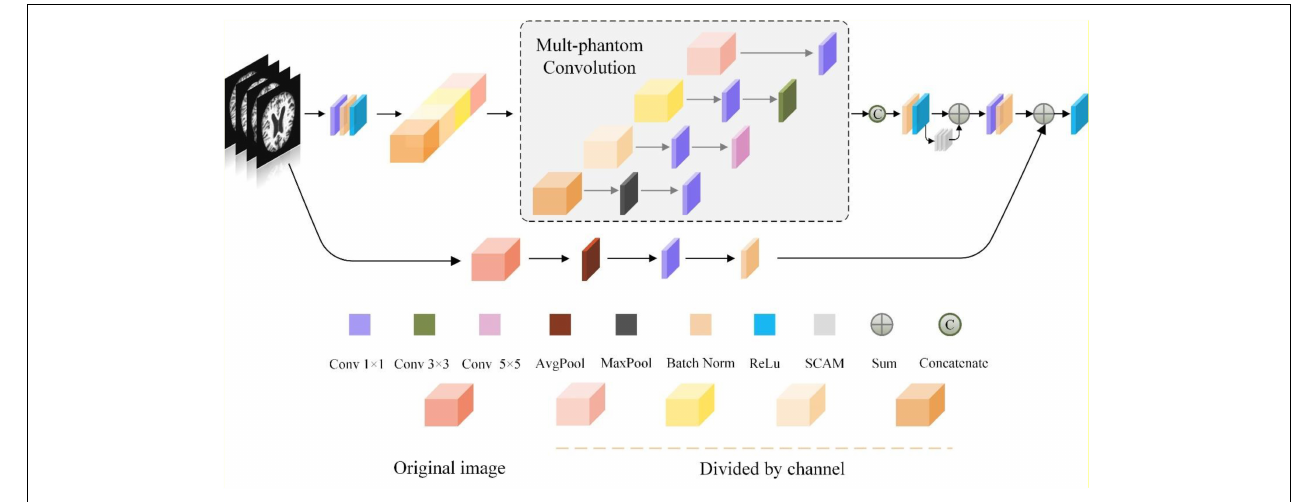
FIGURE 8 | The structure of multi-phantom residual